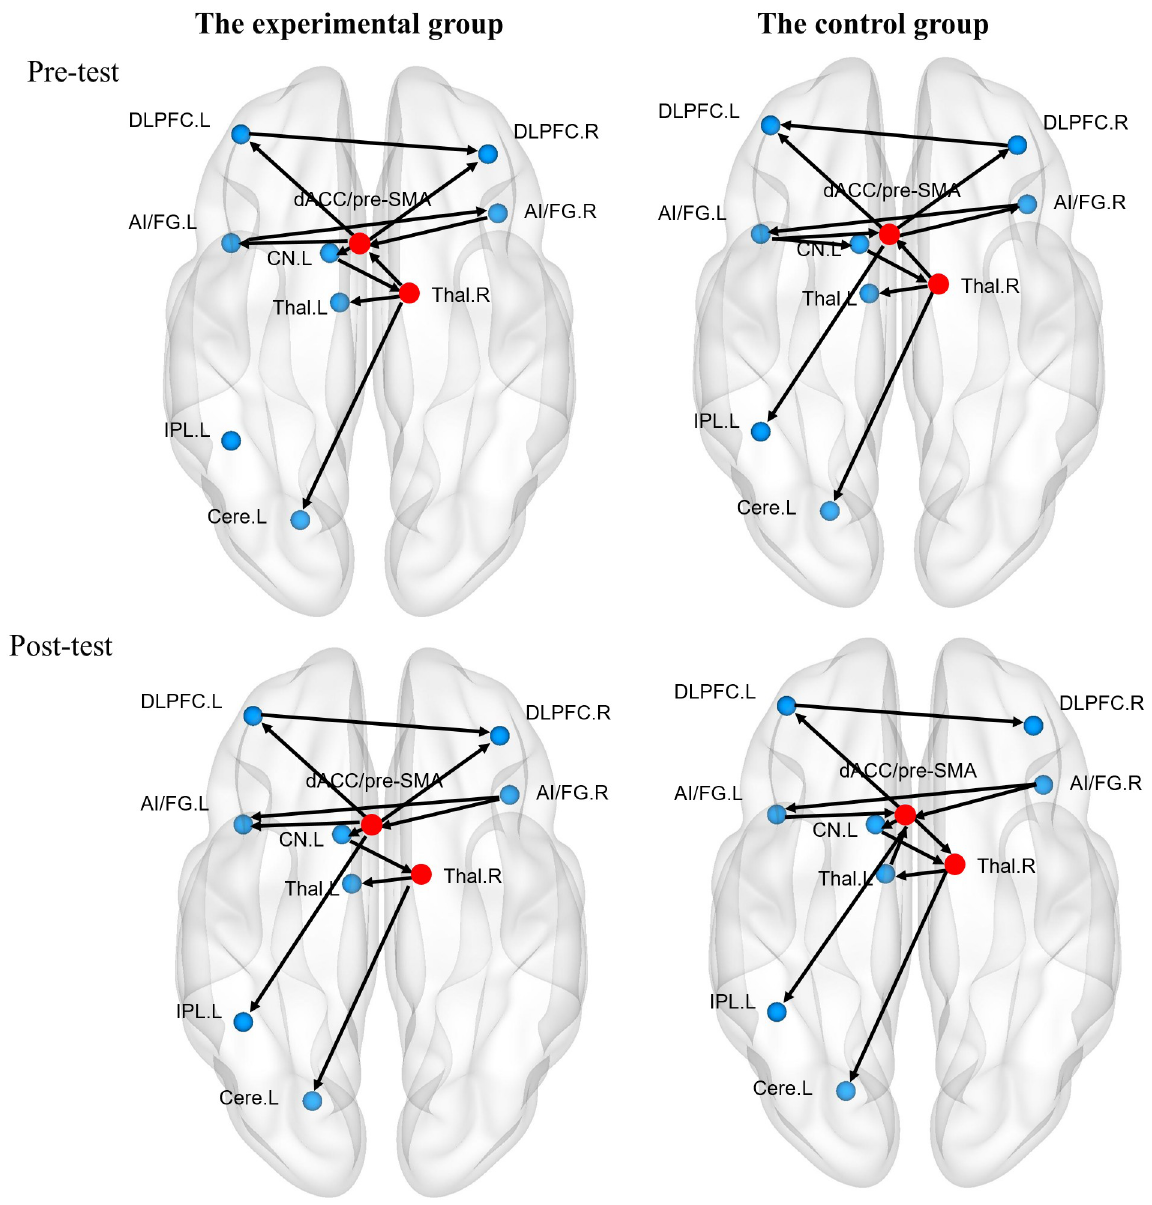
Fig 3. The effective connectivity maps of the experimental and control groups at pre- and post-test sessions. ( A ) The effective connectivity maps of the experimental (left) group and the control group (right) at the pre-test session, ( B ) The effective connectivity maps of the experimental group (left) and the control group (right) at the post-test session. DLPFC. L: the left dorsolateral prefrontal cortex; DLPFC. R: the right dorsolateral prefrontal cortex; dACC/pre-SMA: the dorsal anterior cingulate cortex/pre-supplementary motor area; Thal. L: the left thalamus; Thal. R: the right thalamus; AI/IFG. L: the left anterior insula/inferior frontal gyrus; AI/IFG. R: the right anterior insula/inferior frontal gyrus; CN. L: the left caudate nuclei; IPL. L: the left inferior parietal lobule; Cereb. L: the left cerebellum. NNFI = 0.9645 ± 0.0094) and control group (pre-test: CFI = 0.9850 ± 0.0051, NNFI = 0.9615 ± 0.0109; post-test: CFI = 0.9840 ± 0.0060, NNFI = 0.9605 ± 0.0136). Brain networks were visualized using the BrainNet Viewer [49]. As shown in Fig 3, the dACC/pre-SMA exerted influence on the bilateral middle frontal gyri within the frontal area in both groups at the pre-test session. In addition, the left middle frontal gyrus linked with the